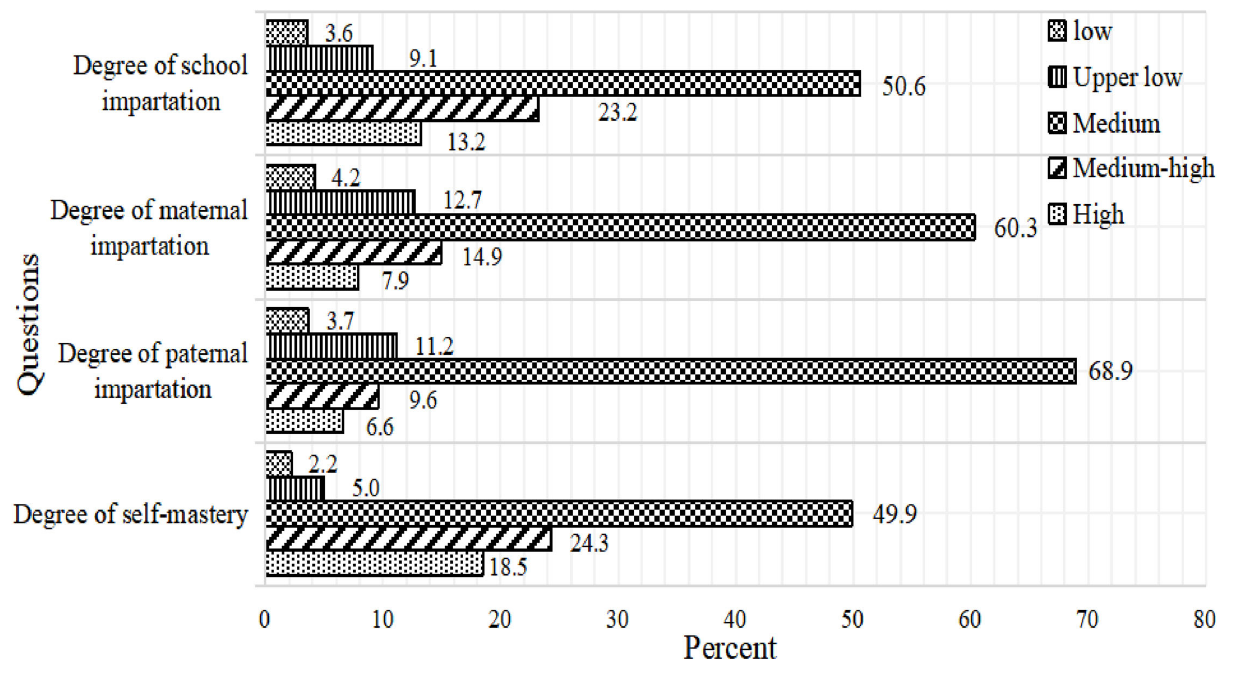
FIGURE 1 | Sex education status of